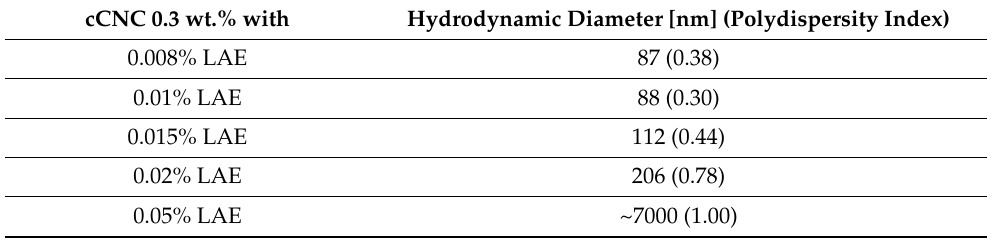
Table 2. The hydrodynamic diameters of cCNC dispersions with increasing LAE concentrations. cCNC 0.3 wt.% with